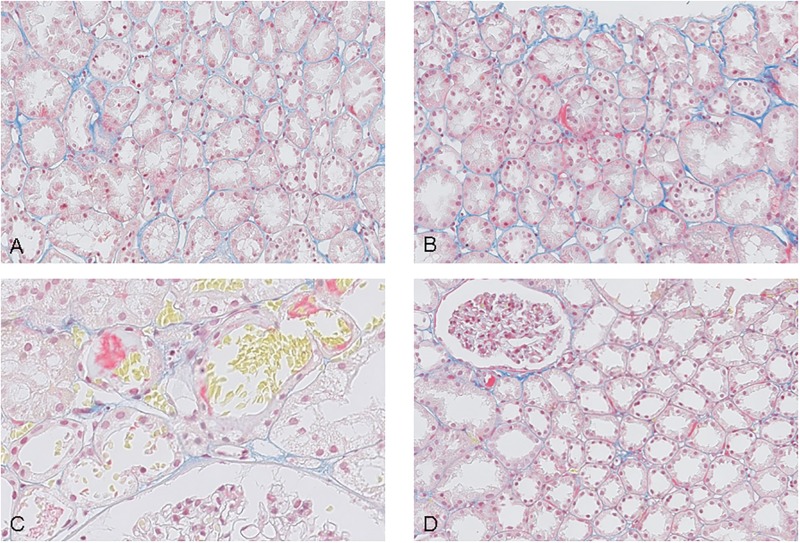
Martius Scarlet Blue stained reperfusion biopsies.Fibrin stains red, collagen blue. Fig 7A reperfusion biopsy negative for fibrin. Fig 7B reperfusion biopsy positive for fibrin Fig 7C reperfusion biopsy positive for fibrin Fig 7D reperfusion biopsy positive for fibrin.